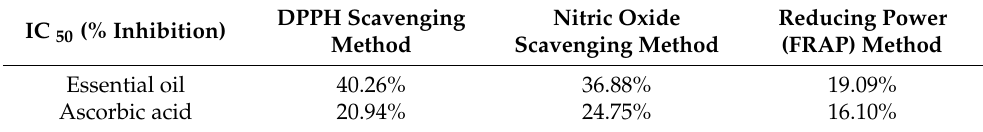
Table 3. The antioxidant half-maximal inhibitory concentration IC 50 inhibition values for the oil.